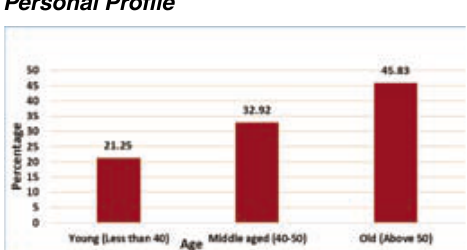
Fig. 4. Distribution of respondents based on Educational Status